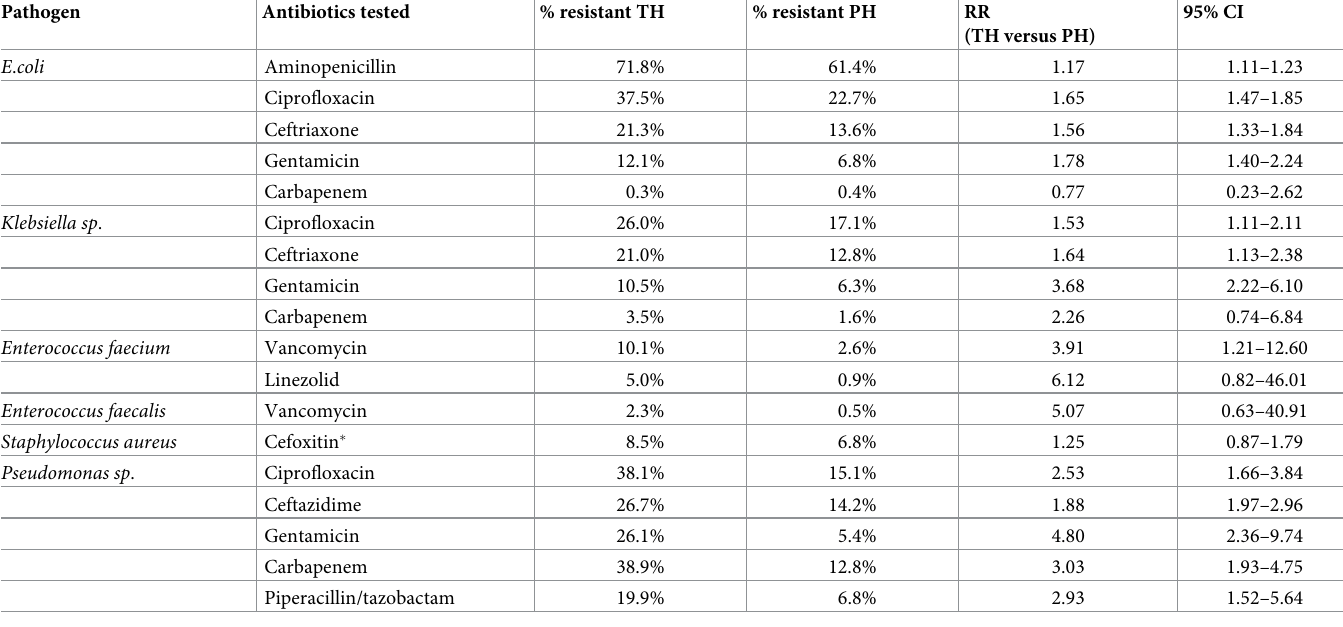
Table 3. Proportion of resistant strains, cumulative incidence risk ratio (RR) (95% confidence